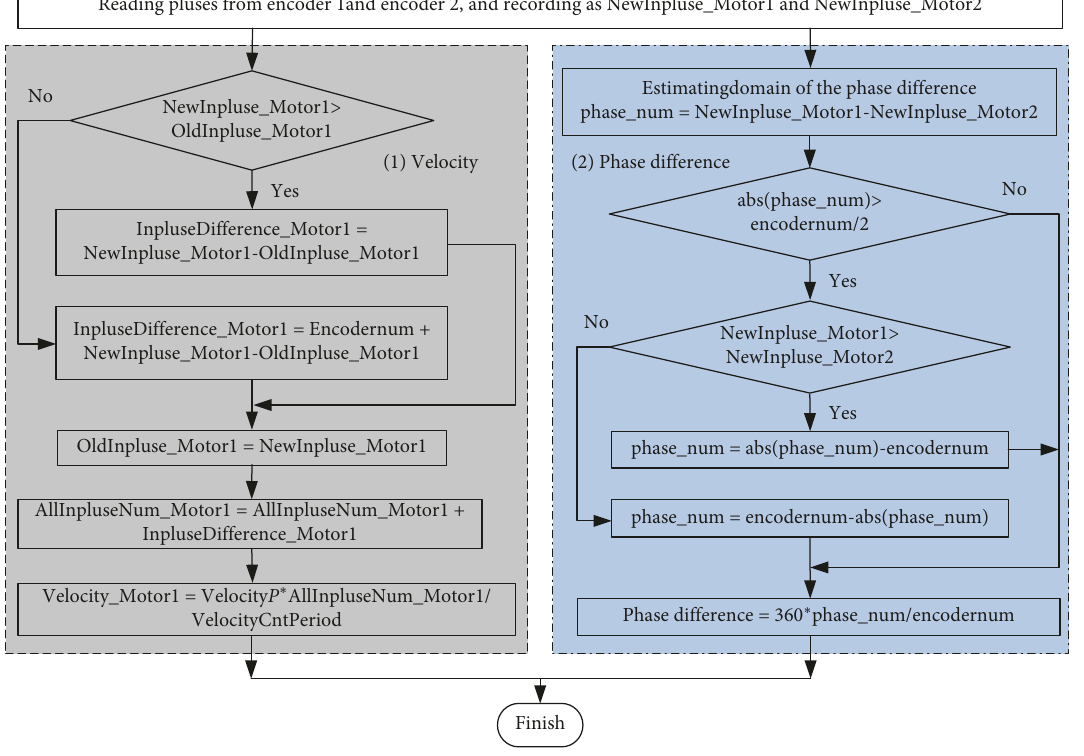
Figure 5: Calculation flow chart of velocity and the phase difference.